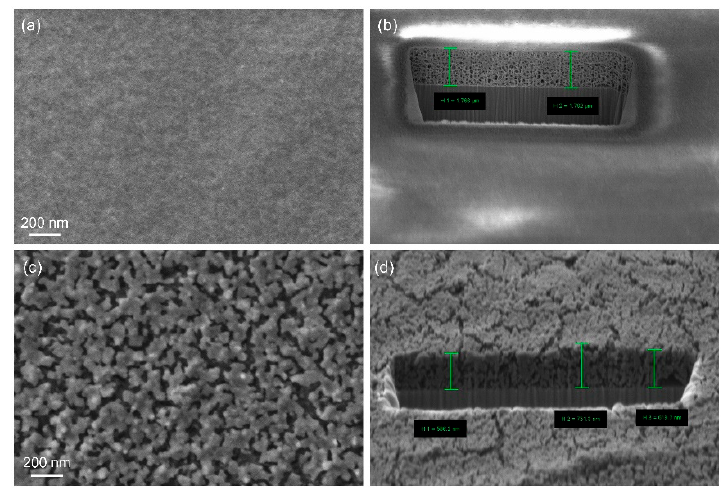
Figure 5. SEM images and focused ion beam (FIB) ablation analysis of mesoporous films of ( a , b ) Al 2 O 3 (average thickness: 1.77 µ m) and ( c , d ) MgO (average thickness: 0.59 µ m) [51].